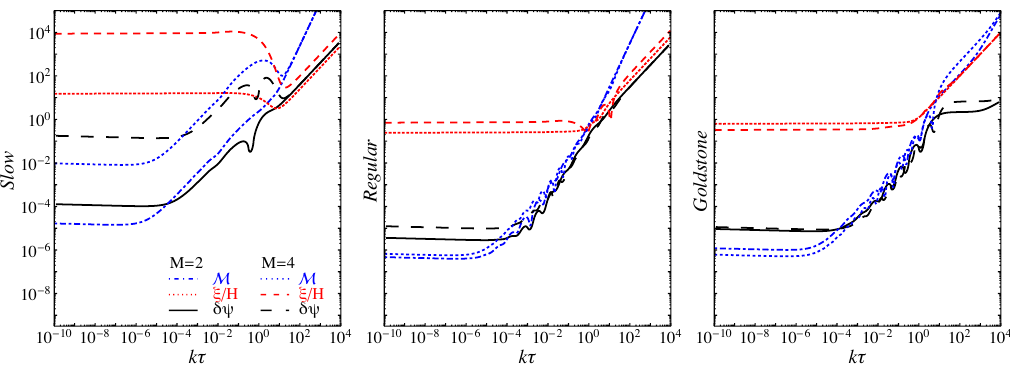
Figure 2 . Evolution of scalar (cid:13)uctuations in Higgsed Gauge-(cid:13)ation. The values of the other parameters here are chosen to be (cid:15) = 0 : 01 and (cid:13) = 4. The three panels show the three independent solutions of the equations of motion, corresponding to the three independent initial conditions in eq. (3.41) . Shown are the solutions for two di(cid:11)erent values of the Higgs vev, corresponding to M = 2 and M =